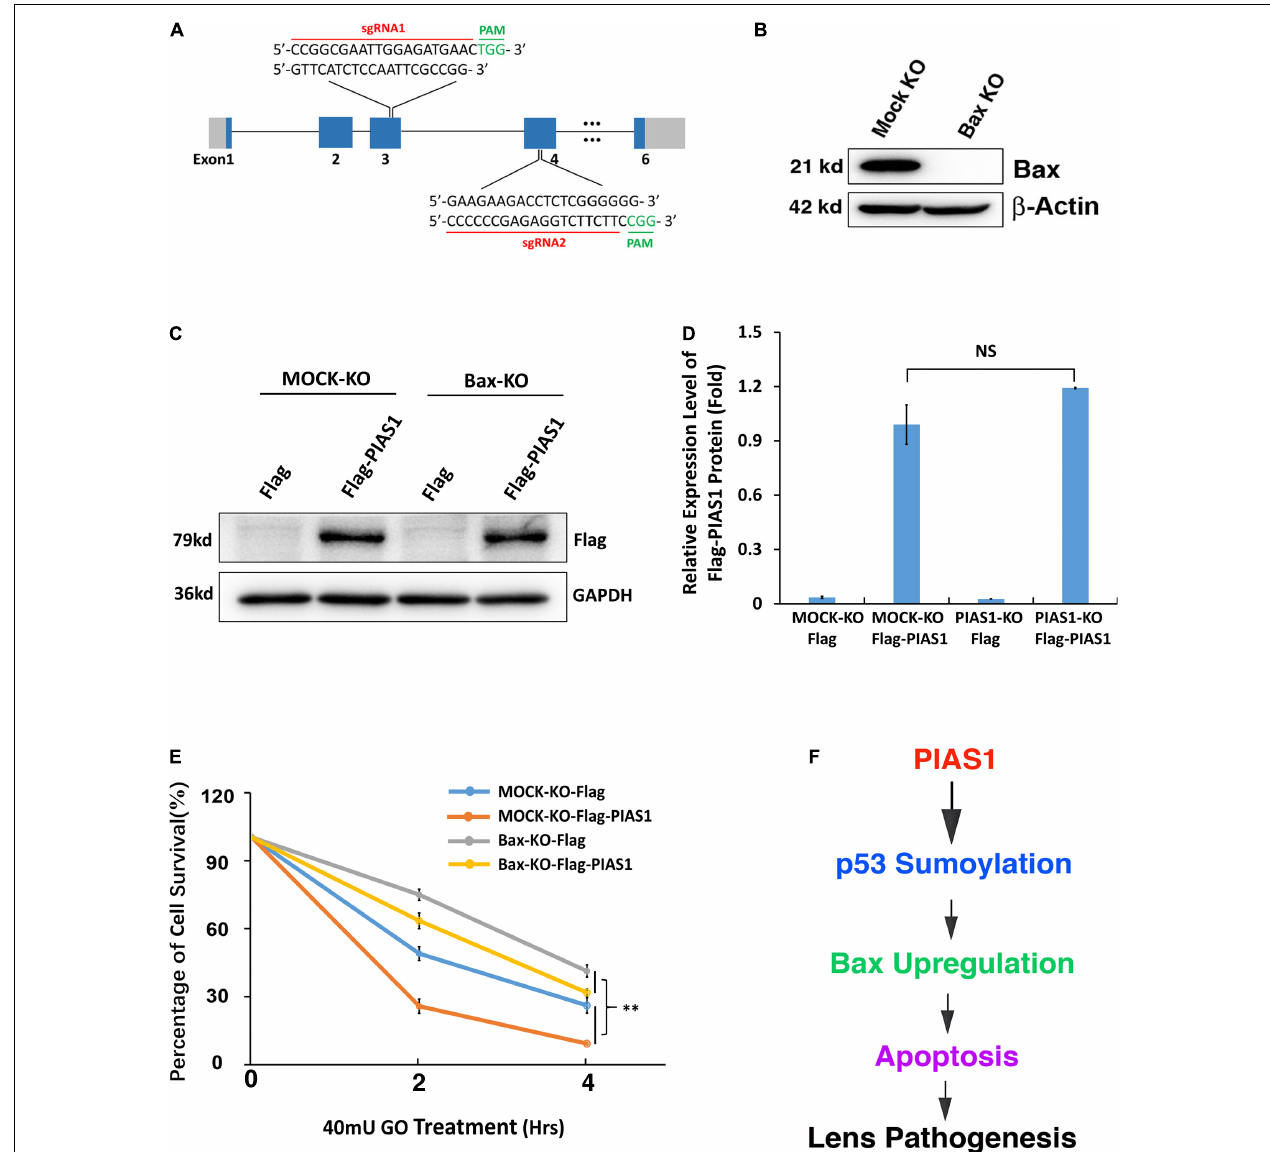
FIGURE 8 | Knockout of endogenous Bax partially inhibited the stress-induced apoptosis in lens epithelial cells expressing exogenous PIAS1. (A) Schematic diagram of the strategy for generating the Bax knockout cells by CRISPR/Cas9 gene editing technology. (B) Western blot analysis of the expression levels of Bax in α TN4-1 MOCK-KO and Bax knockout (Bax-KO) cells. Note that Bax was not detectable in Bax-KO cells. The β -actin was used as a loading control. (C) MOCK-KO and Bax-KO cells were transfected with Flag or Flag-PIAS1 as indicated. Forty-eight hours after transfection, Western blot analysis of the expression levels of exogenous PIAS1 was conducted in MOCK-KO and Bax-KO cells. (D) Quantification of the Western blot results in panel (C) . (E) The transfected cells were then induced to apoptosis under 40 mU GO for 2 or 4 h and cell viability was measured by CellTiter-Glo R (cid:13) Luminescent Cell Viability Assay. (F) Diagram shows how PIAS1 regulates oxidative stress-induced apoptosis of lens epithelial cells, leading to cataractogenesis. All experiments were repeated three times. Error bar represents standard deviation, N = 3. NS, not significant, ∗∗ p <